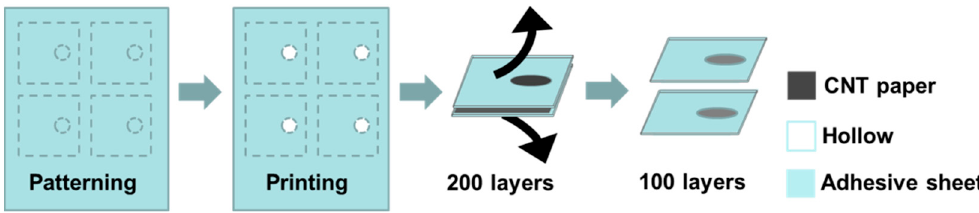
Figure 1. Inverse-ordered fabrication from 200-layered to 100-layered CNT sheet